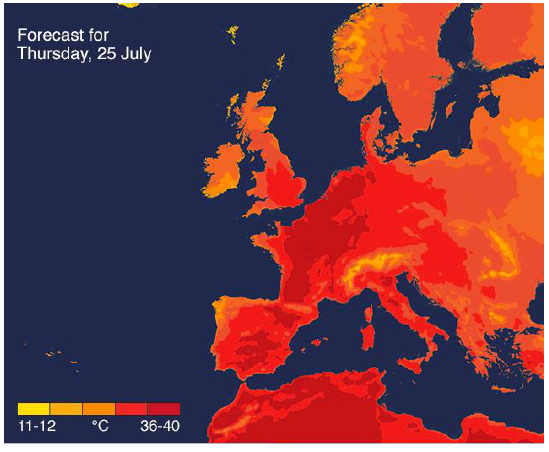
Figure 1. Record temperatures across Europe (forecast for 25 July 2019, source: BBC Weather).